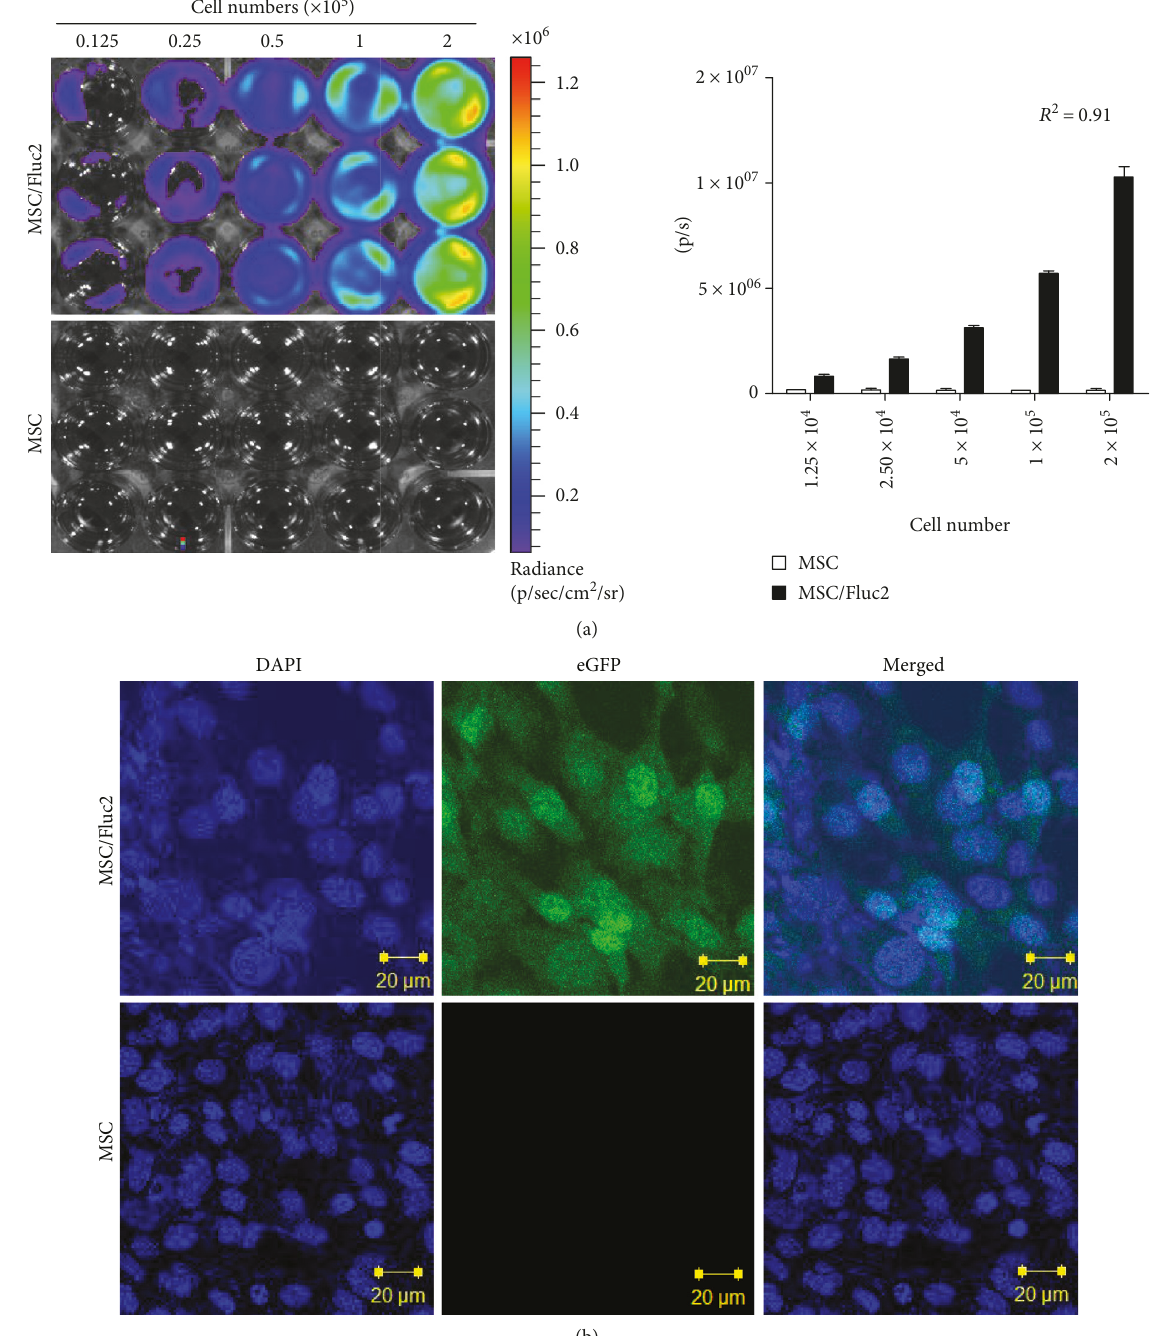
Figure 2: Characterization of MSC/Fluc2 cells (a) BLI and quantitation of Fluc activity in transduced MSCs (MSC/Fluc2) at various concentrations. (b) eGFP confocal microscopy in transduced MSCs